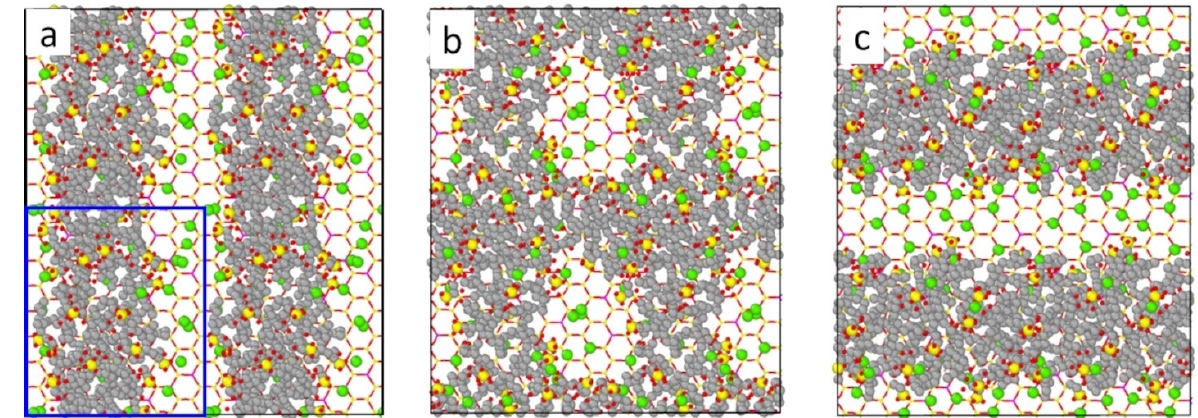
Figure 7. Snapshots from MD simulations of 32 AOT with Ca 2+ at ( a ) 300 K, ( b ) immediately after heating to 350 K, and ( c ) equilibrium at 350 K. A 2 × 2 repeat of the simulation cell is shown in the xy plane (looking down on the mica surface). The simulation cell is indicated by the blue box. Atoms not representing the AOT micelle or upper muscovite layer have been removed for clarity.